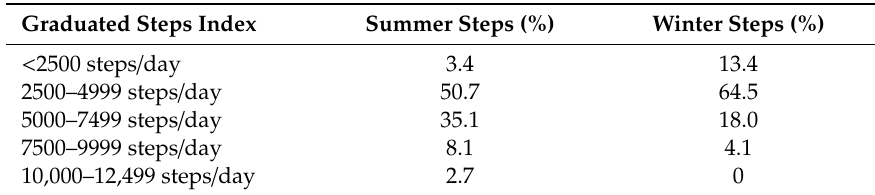
Table 3. Application of Tudor Locke’s graduated index to the number of steps taken by research participants in summer and